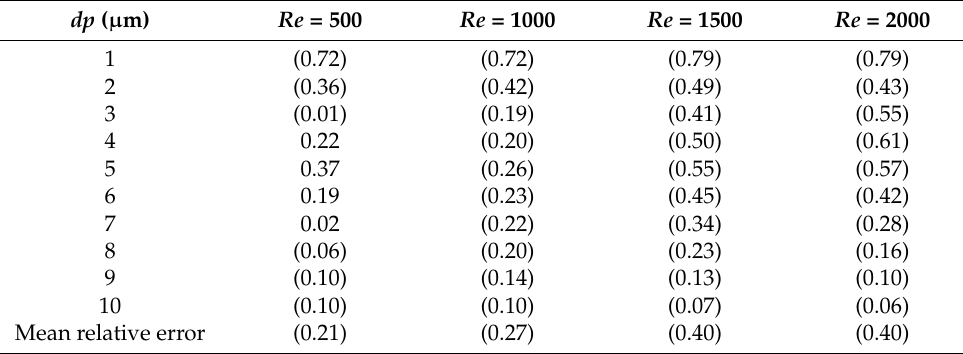
Table 1. The relative error between the prediction value and simulation